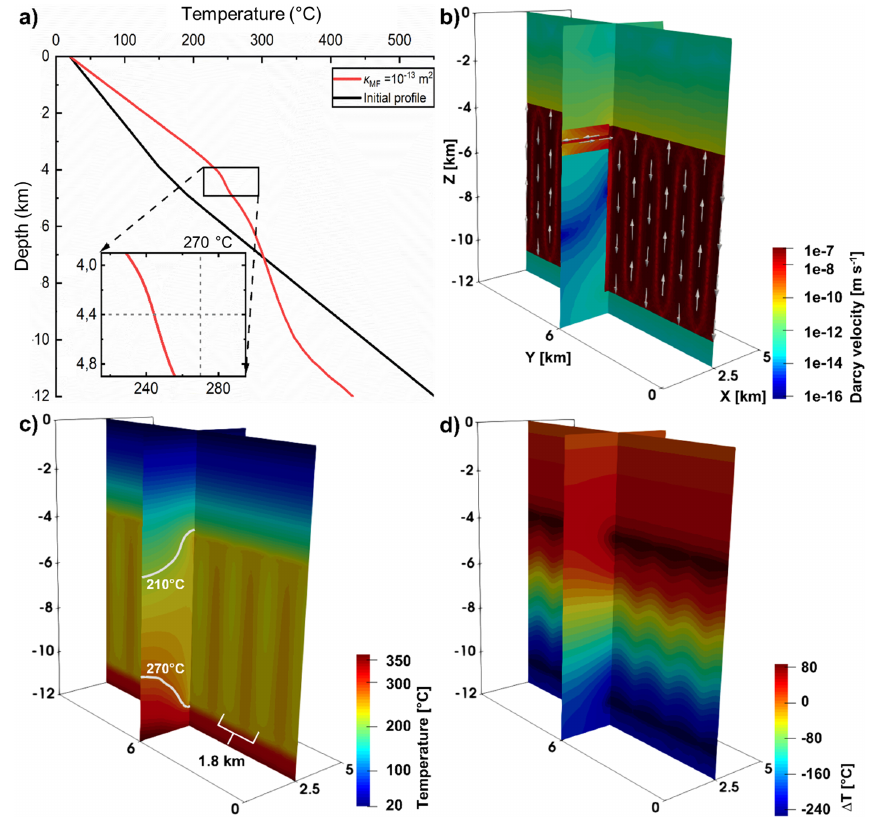
Figure 4. Fluid-flow and temperature fields of the reference case. (a) Temperature-depth profiles that follow the western boundary of the Piesberg quarry (Fig. 2b) at the initial time and when T max is reached, respectively. At 1Myr, cross-sectional views of the (b) flow field with arrows representing the preferential fluid-flow pathways and (c) resulting temperature distributions. The 210 and 270 ◦ C isotherms are highlighted to indicate the dominant heat-transfer types and (d) temperature differences compared to the initial conductive temperature